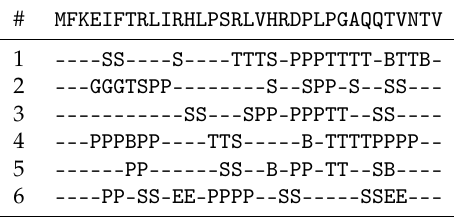
Figure 8. ( a ) Stacked secondary-structure histograms per amino acid residue of KEIF as obtained from MD simulations. Three different types of helices included in helical content: (i) α -helix, (ii) 3 10 -helix, and (iii) π -helix. This analysis did not include the PPII helix. ( b ) Ramachandran plot of KEIF as obtained from MD simulations. Table 5. Secondary structure per amino acid of representative structures from top six clusters of MD simulation of KEIF, as obtained by using DSSPPII analysis [31]. Secondary structure per amino acid represented according to standard DSSP